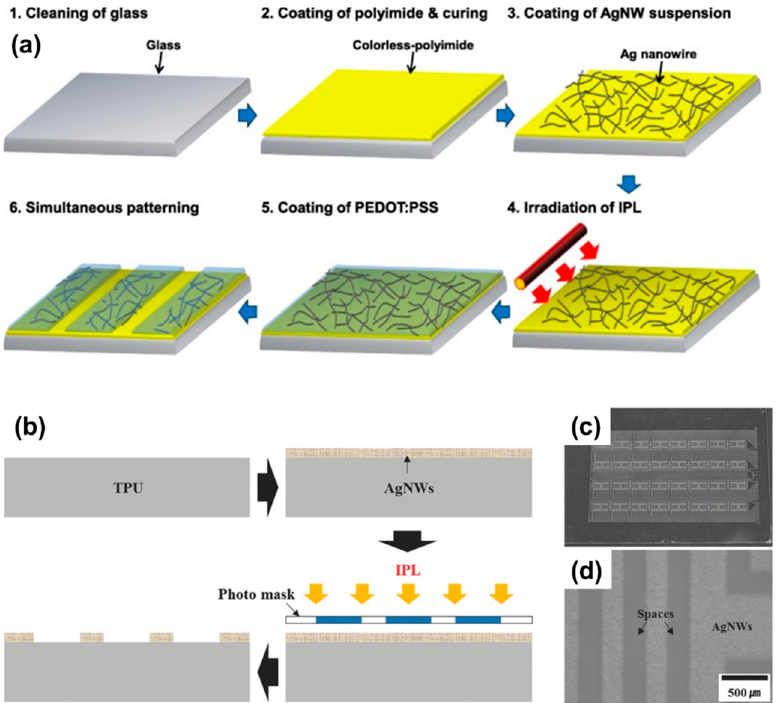
Figure 6. ( a ) A schematic description of the fabrication process for AgNW/PEDOT:PSS-based electrode on cPI substrate. Reproduced with permission from Ref. [16]. Copyright 2015, Elsevier. ( b ) Schematic illustration of the procedure for patterning AgNWs on a stretchable polymer, ( c ) a fabricated capacitive sensor (diagonal length of the panel was 125 mm), and ( d ) fabricated AgNW patterns on the stretchable polymer. Reproduced with permission from Ref. [41]. Copyright 2016,